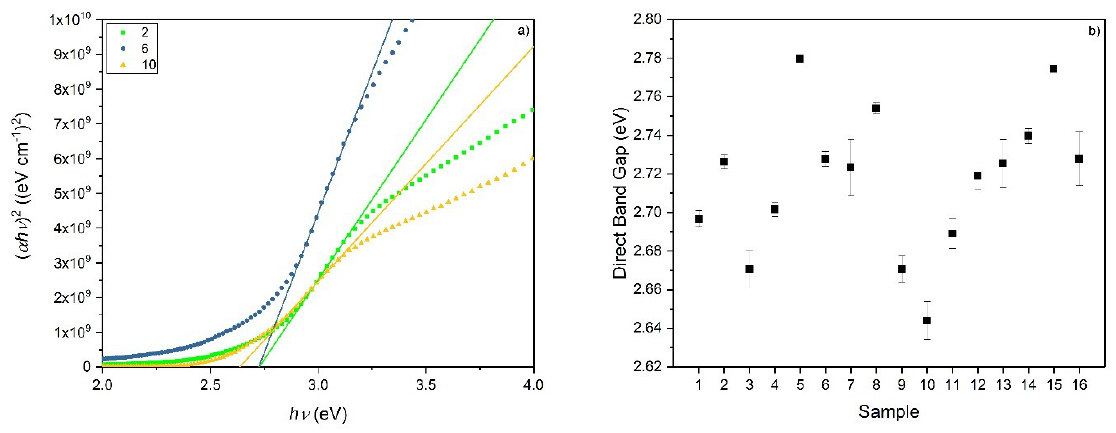
Figure 7. ( a ) Plot of ( α h ν ) 2 vs. ( h ν ) to determine the direct band gap; ( b ) direct band gap of coatings Figure 7. (a ) Plot of ( αhν ) 2 vs. ( hν ) to determine the direct band gap; ( b ) direct band gap of coatings (N = 4 with (N = 4 with SD).